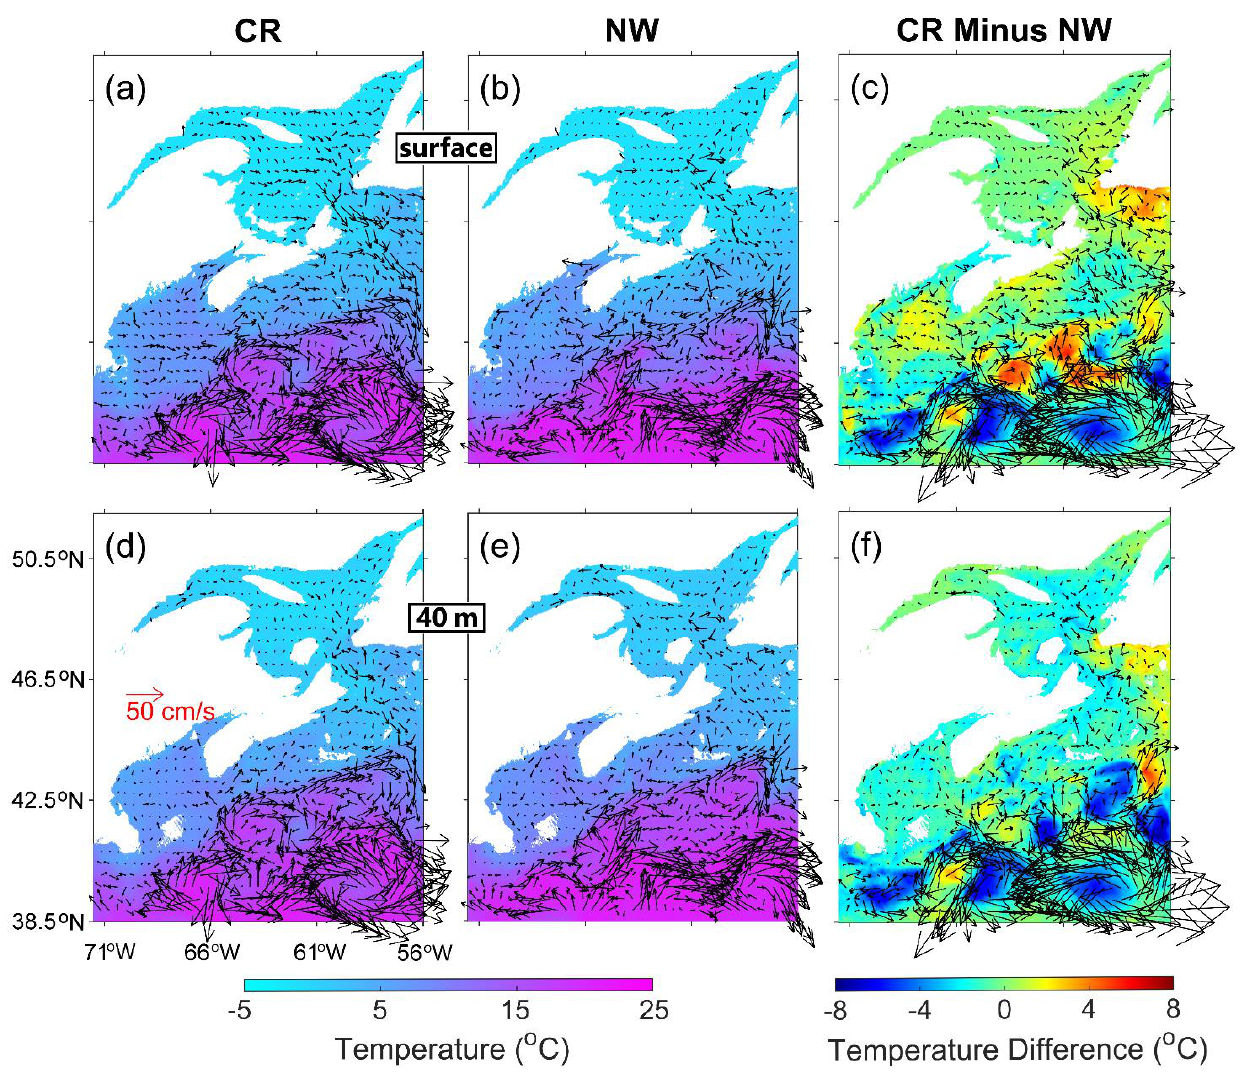
Figure 8. Monthly-mean currents and temperature in February 2018 produced by submodel L2 at ( a , b ) the sea surface and ( d , e ) 40 m over the L2 domain in cases ( a , d ) CR and ( b , e ) NW. Differences in the monthly-mean currents and temperature between cases CR and NW at ( c ) the sea surface and ( f ) 40 m. For clarity, velocity vectors are plotted at every 14th model grid point. NW The February-mean SST ( T